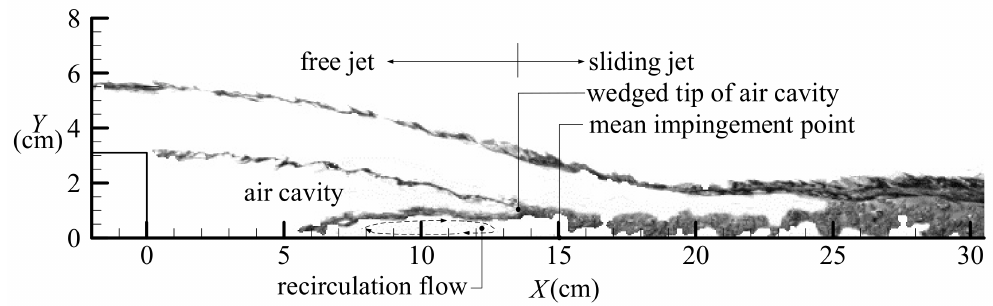
Figure 4. A global view of superposing three instantaneous SIM images captured in the FOVS 1